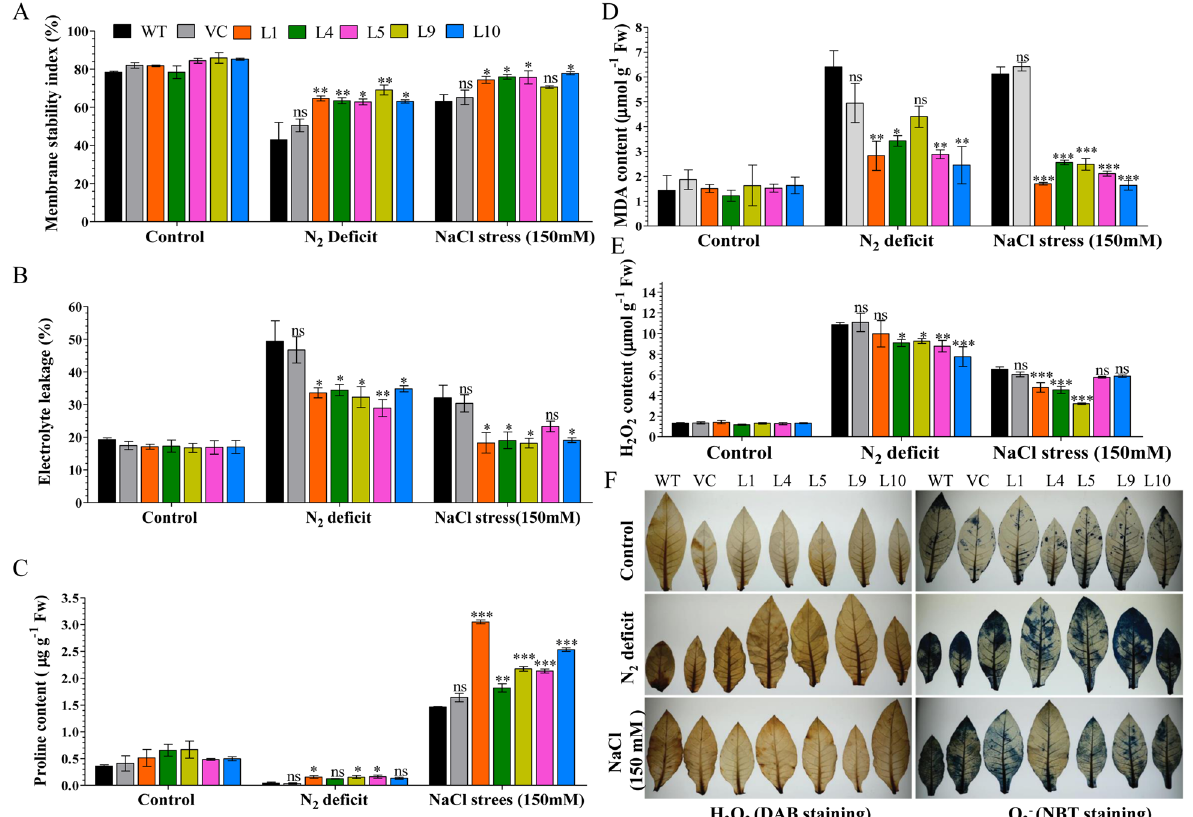
Figure 4. Physiological status and ROS analysis of transgenic plants. Comparative analysis of ( A ) membrane stability, ( B ) electrolyte leakage and ( C ) proline accumulation ( D ) lipid peroxidation (MDA content), ( E ) H 2 O 2 content and ( F ) in vivo localization of ROS in transgenic lines, WT and VC plants under control, nitrogen deficit and salt stress condition. Bars represent means ± standard error, and ‘*’, ‘**’ and ‘***’ designates for significant differences at P < 0.05, P < 0.01 and P < 0.001, respectively and ‘ns’ represents no significant